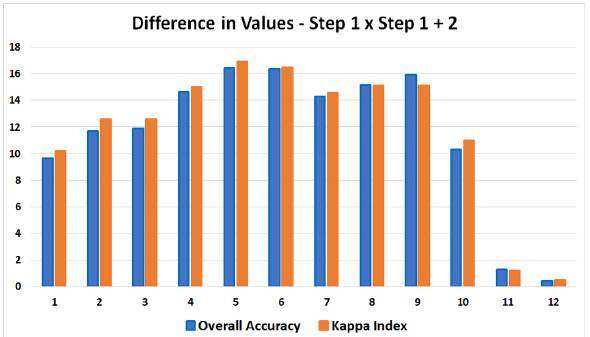
Figure 12. Difference of Overall Accuracy and Index Values between the Step 1+2 method and Step 1